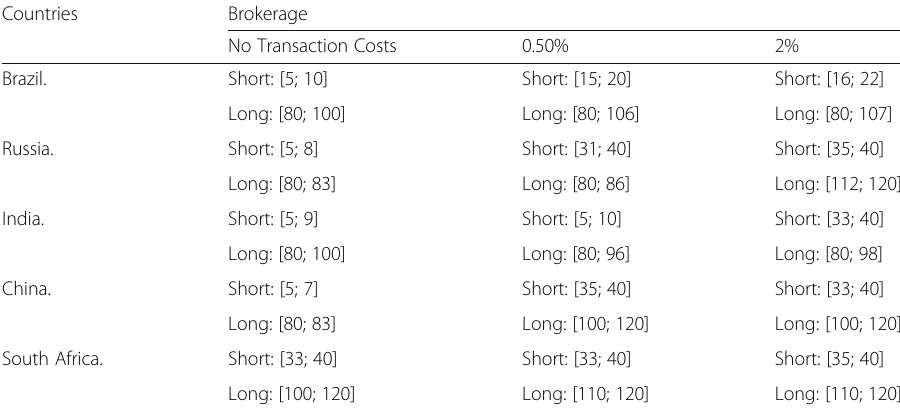
No Transaction Costs 0.50%